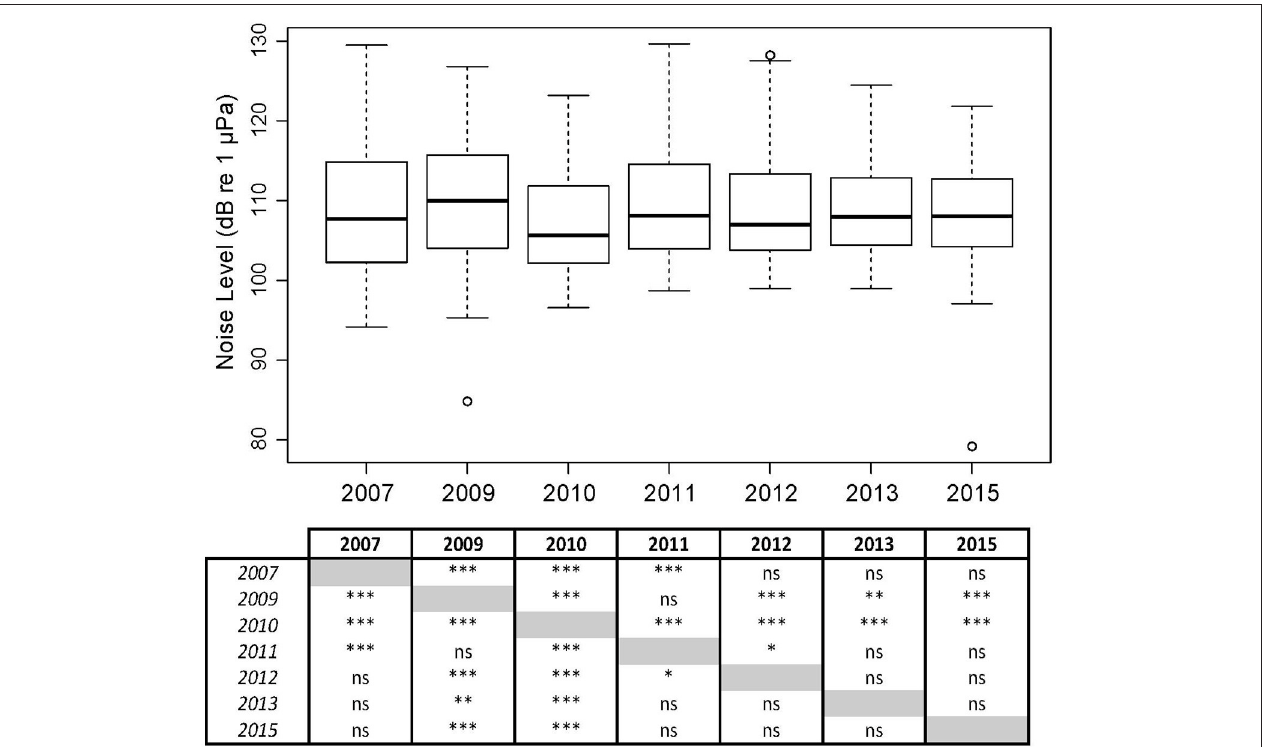
FIGURE 9 | Overall broadband noise levels (NL_BB) at Mosman Bay over the month of January across a 9-year period, including a table of significant differences as determined by Wilcoxon-Mann-Whitney Tests: ≤ 0.001 ***; ≤ 0.01 **; ≤ 0.05 *.